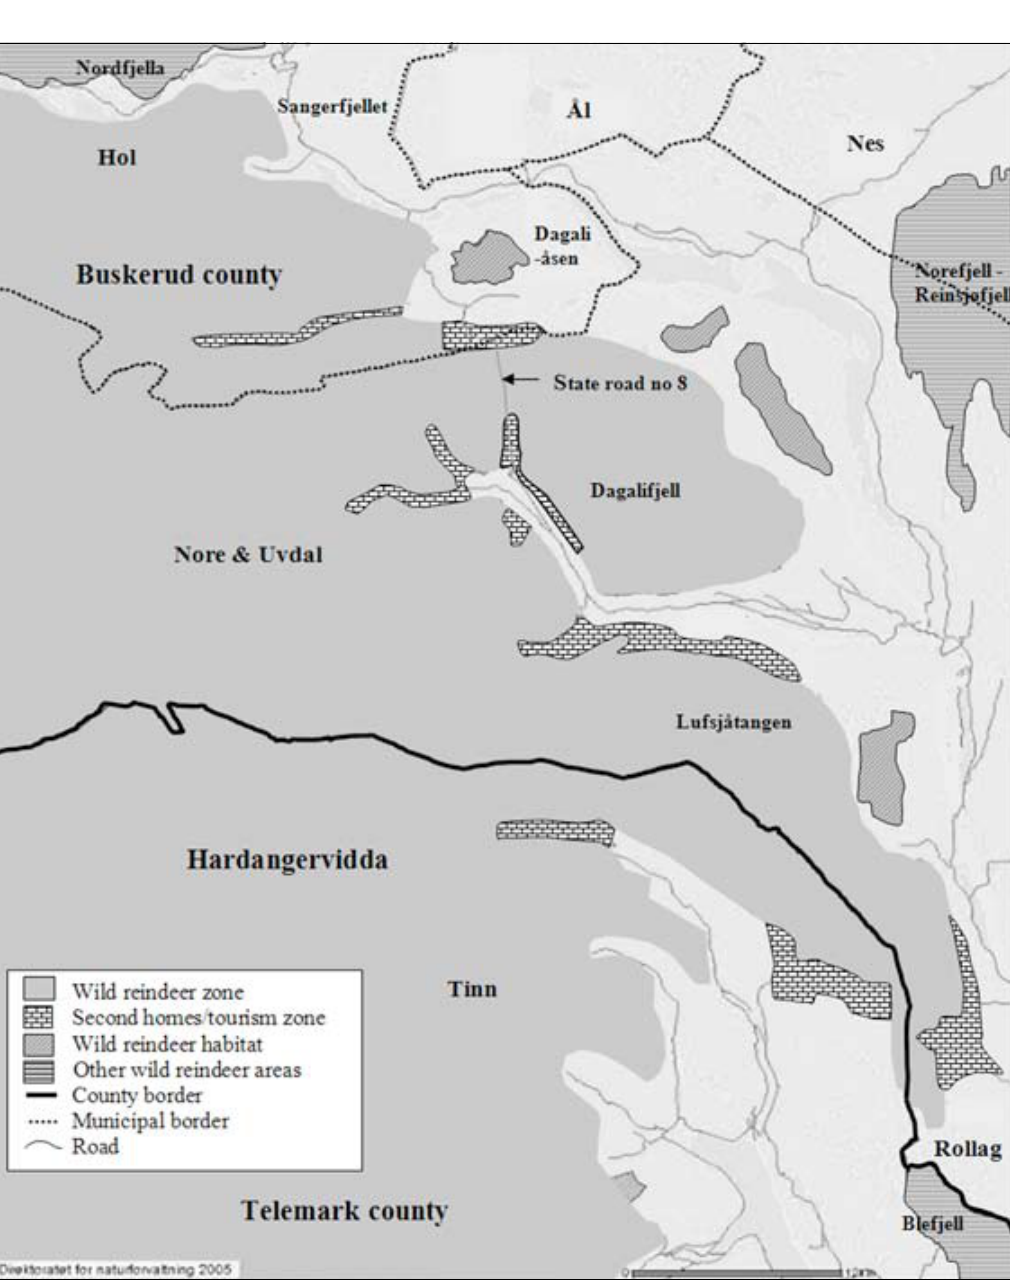
Fig. 3. The Hardangervidda East County Development Plan, simplified 1995